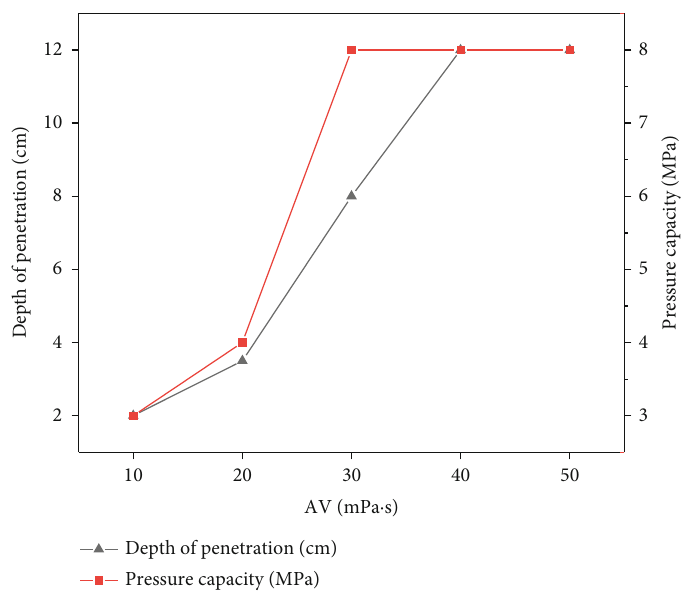
Figure 5: The e ff ect of carrier fl uid viscosity on the pressure-bearing capacity and invasion depth of the plugging layer.